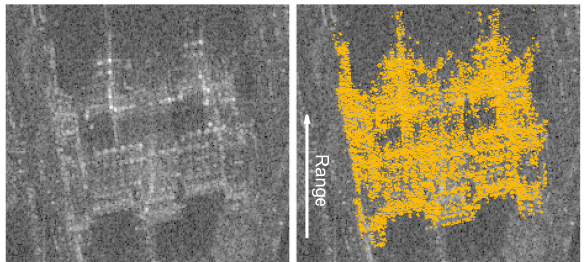
Table 1. SAR Data acquisition and processing parameters.